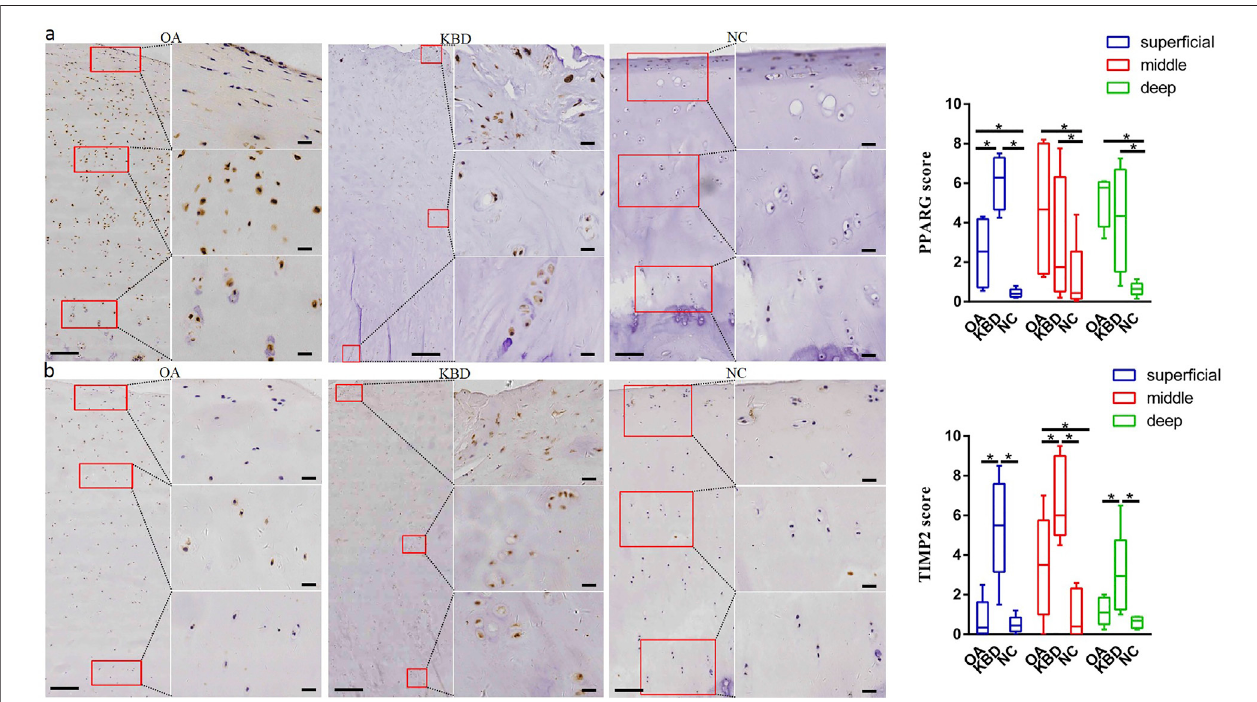
FIGURE 2 | Representative immunohistochemistry staining of PPARG (A) and TIMP2 (B) in OA, KBD, and normal control cartilage tissues. The scores of different areas (super fi cial, middle, and deep) in cartilage tissues displayed by box plot ( n (cid:1) 5). * p < 0.05.